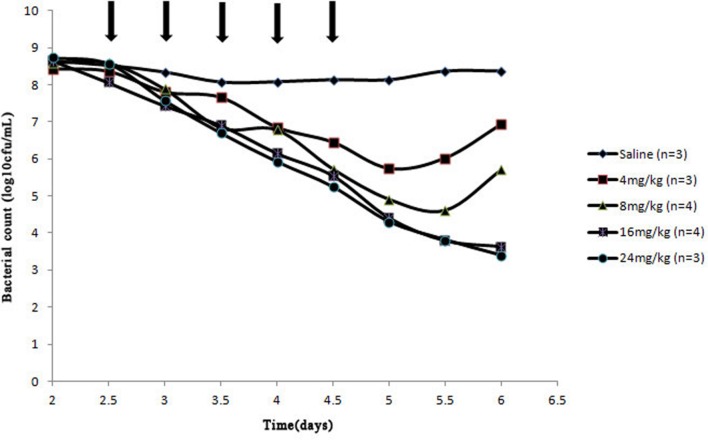
Effect of cefquinome at different doses on bacterial survival in the tissue-cage model (12 h intervals). Three days after infection, different doses (0, 4, 8, 16, and 24 mg/kg of body weight by use of intragluteal injection) of cefquinome were administered twice daily for 2.5 days (indicated by the arrow). n is the animal number per group.